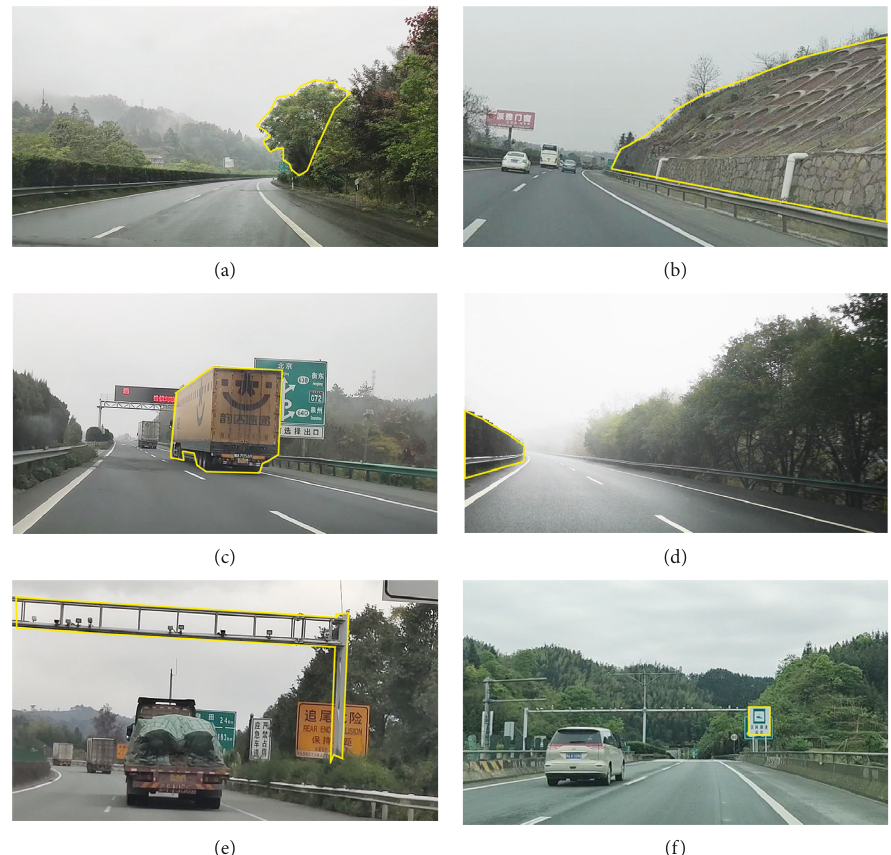
Figure 3: Illustration of occlusion factors (for details, refer to the text). (a) Plant occlusion. (b) Slope occlusion wall. (c) Dynamic occlusion of codirectional vehicles. (d) Occlusion from central divider. (e) Occlusion of monitoring facilities. (f) Occlusion of traffic signs.